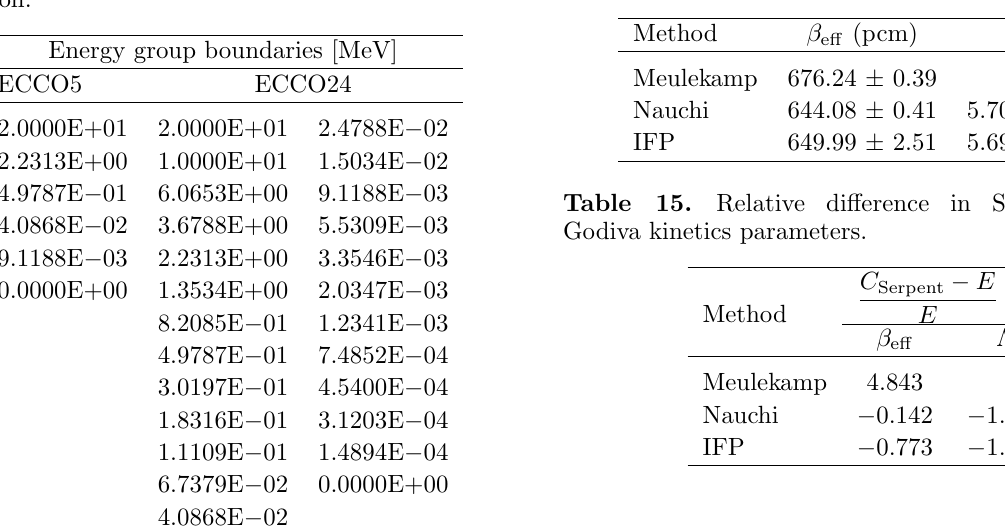
Table 14. Serpent-evaluated Godiva kinetics parameters.